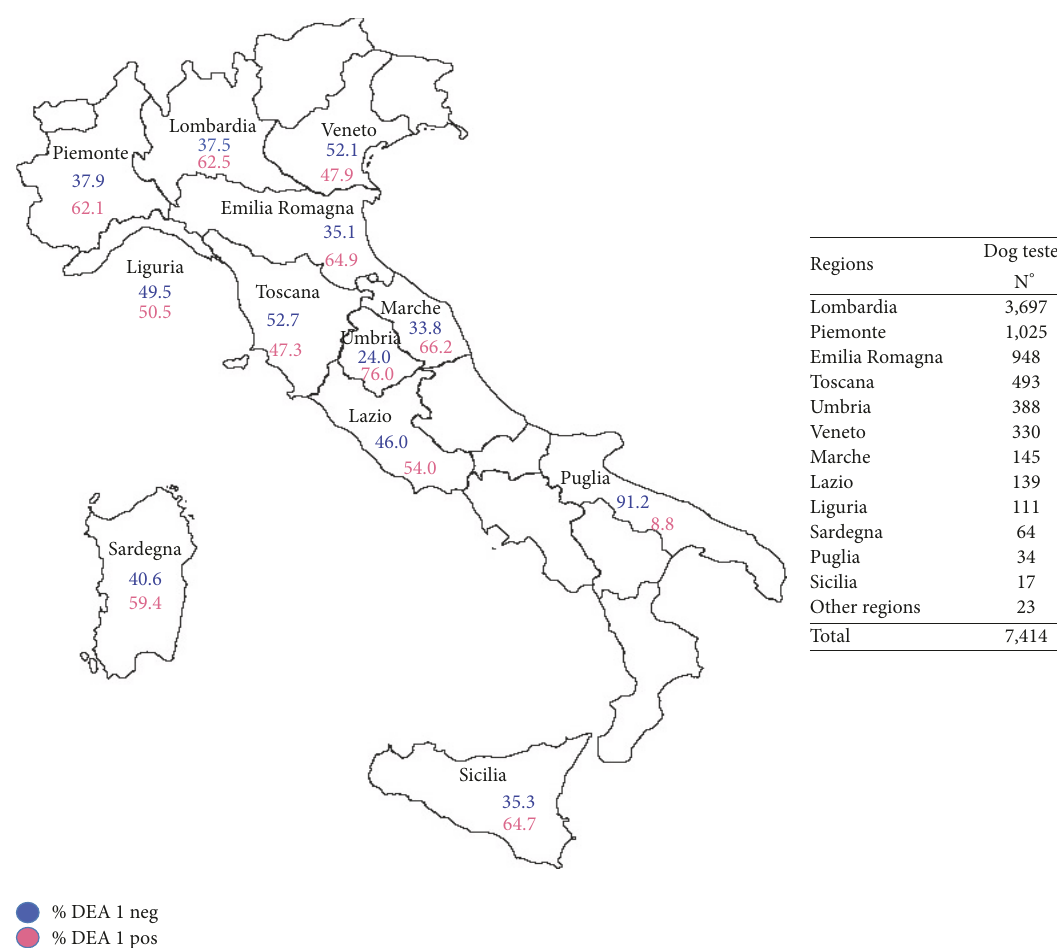
Figure 1: Distribution of DEA 1 negative and positive dogs in Italians regions (according to raw data retrieved from http://www.dog- blooddonors.it